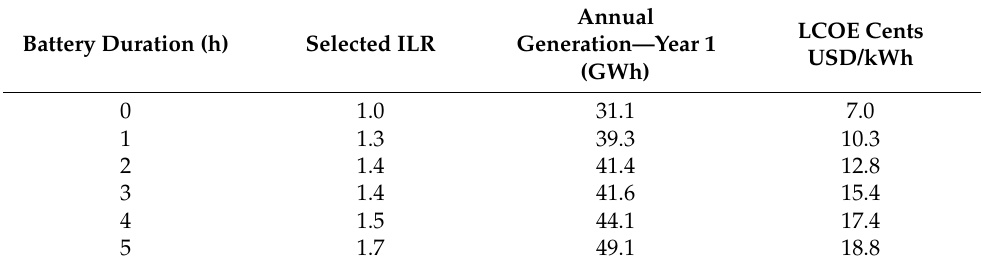
Table 6. Selected ILR with single axis.